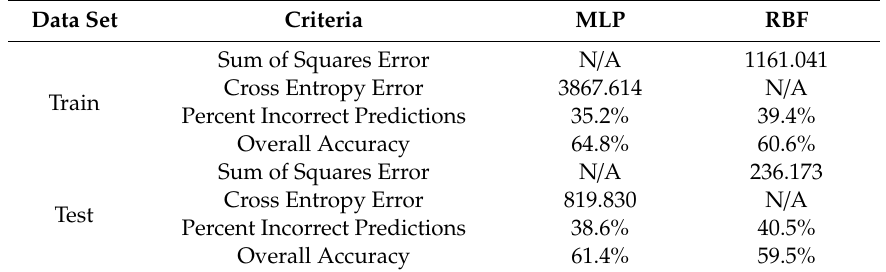
Table 3. Predictive ANNs model confusion rate and area under curve (AUC) per cause